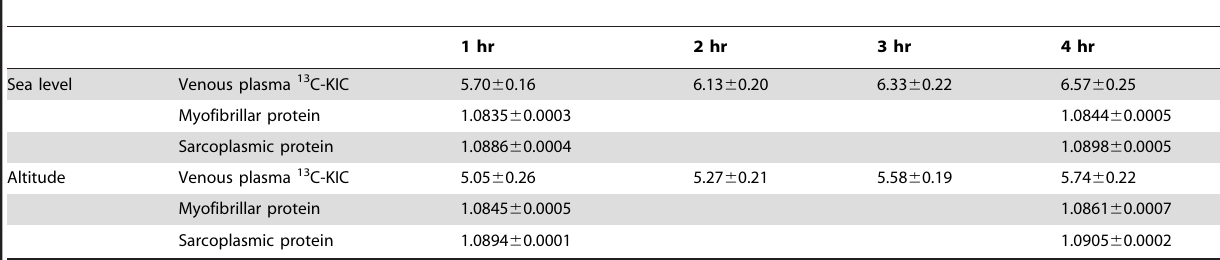
Table 2. Venous plasma KIC and muscle protein bound leucine enrichments.